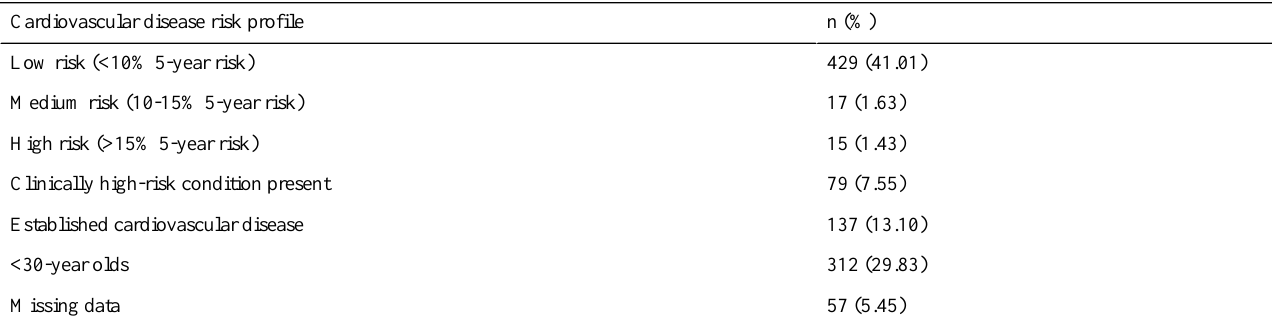
Table 4. Cardiovascular and diabetes risk profile for 1046 people.